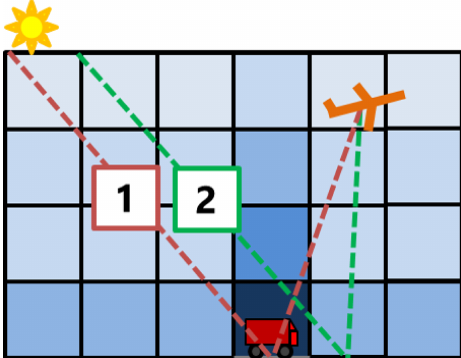
Figure 8. Sketch of two main optical paths for an airborne spec- trometer pointing at (1) a road in grey and (2) at a pixel aside the